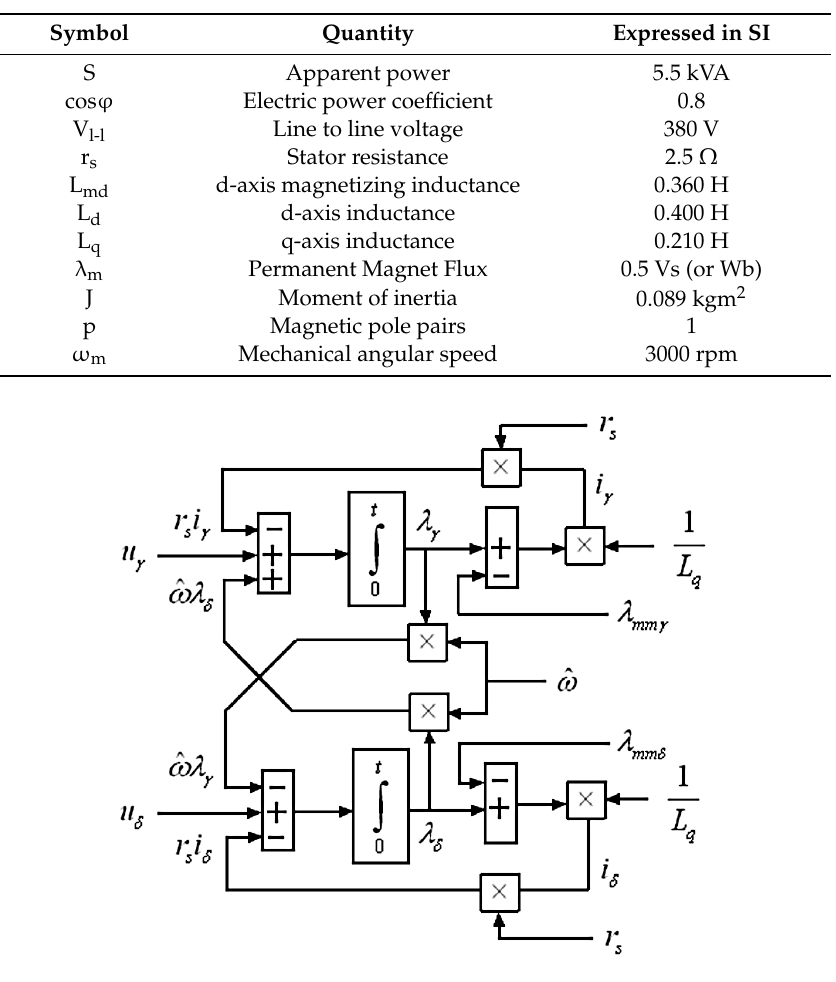
Figure 6. The PMSM model in γδ reference frame that is used as basis to form the sliding mode observer (SMO) for speed and position estimation.